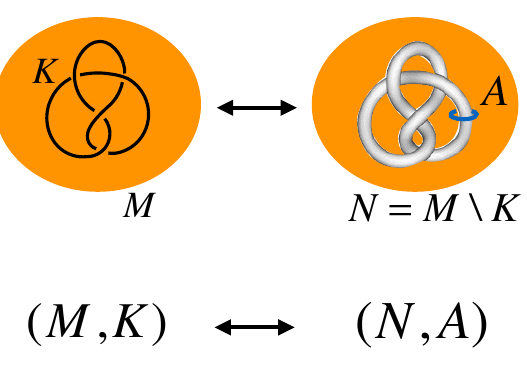
Figure 1 . The choice of a knot K inside a closed 3-manifold M can be alternatively described by a choice of knot complement N and a boundary cycle A 2 H 1 ( @N; Z